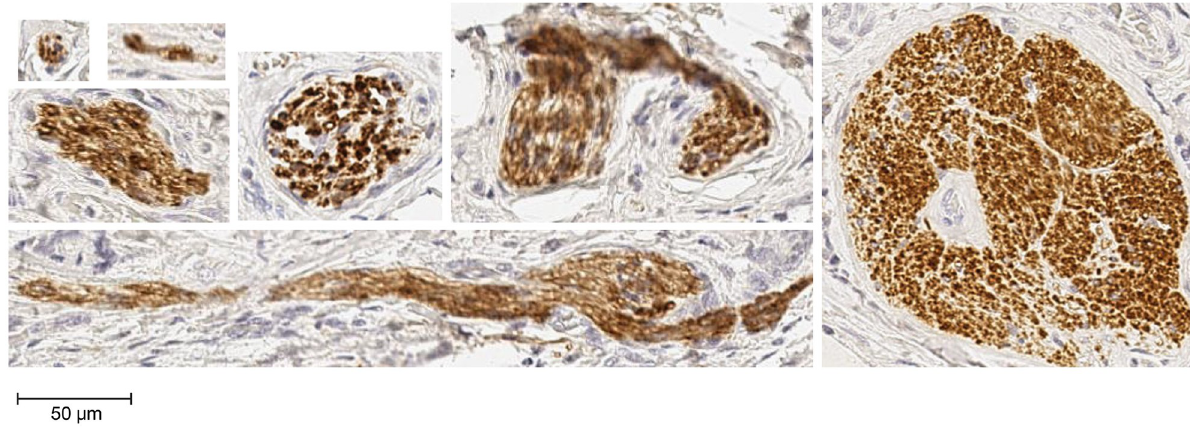
Fig 1. Examples of variation in the size of nerves.